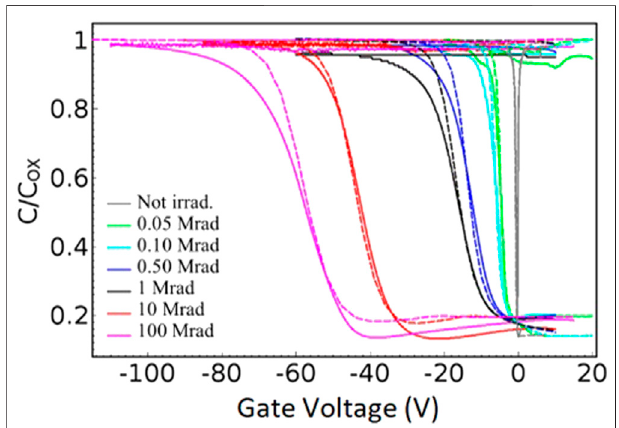
FIGURE 9 | C-V characteristics of IFX MOS capacitors: comparison between simulated and experimental data for 6 ″ process (solid line measurements, dashed lines